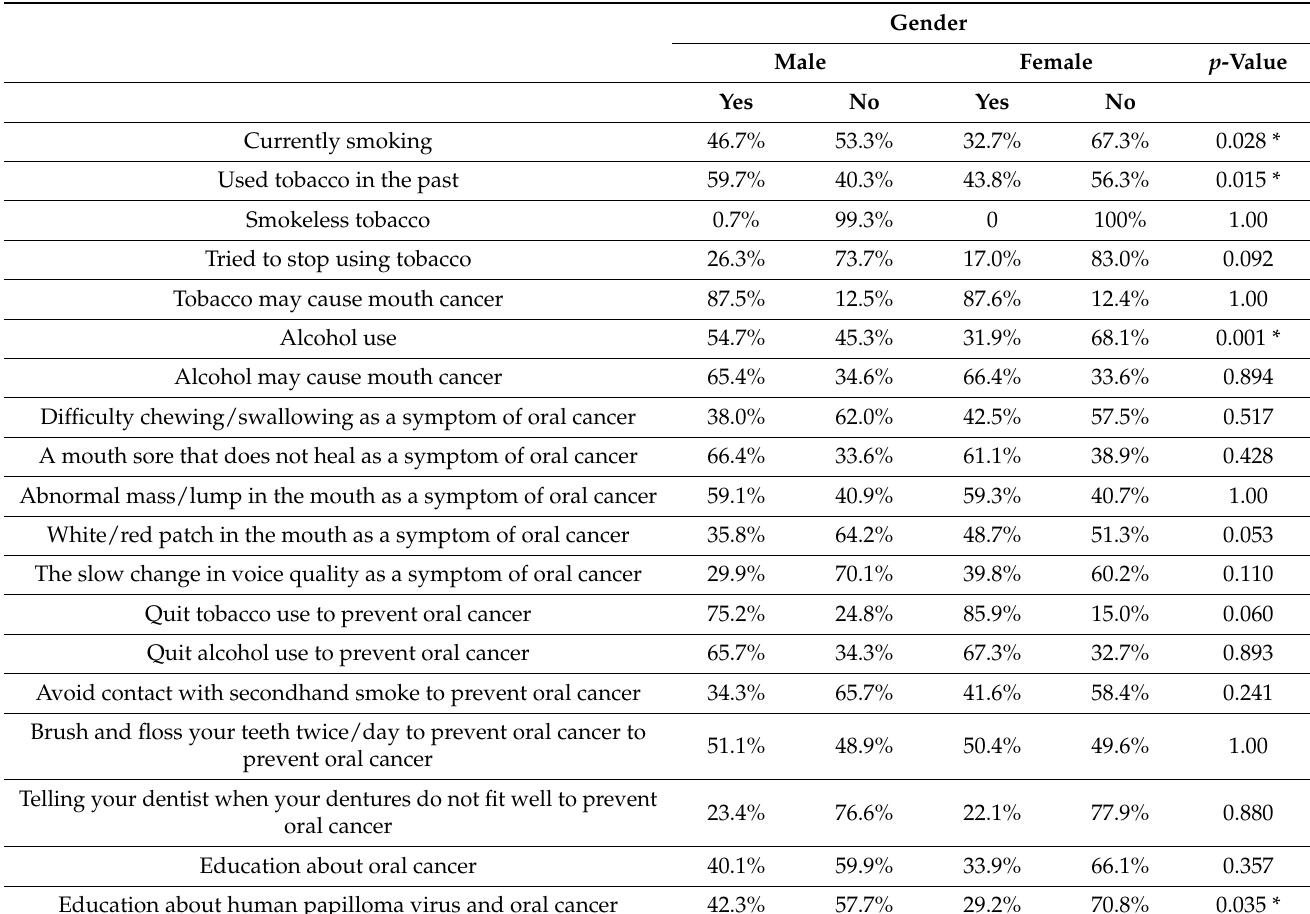
Table 1. Comparison of survey questions according to gender. * shows statistical significance ( p < 0.05).